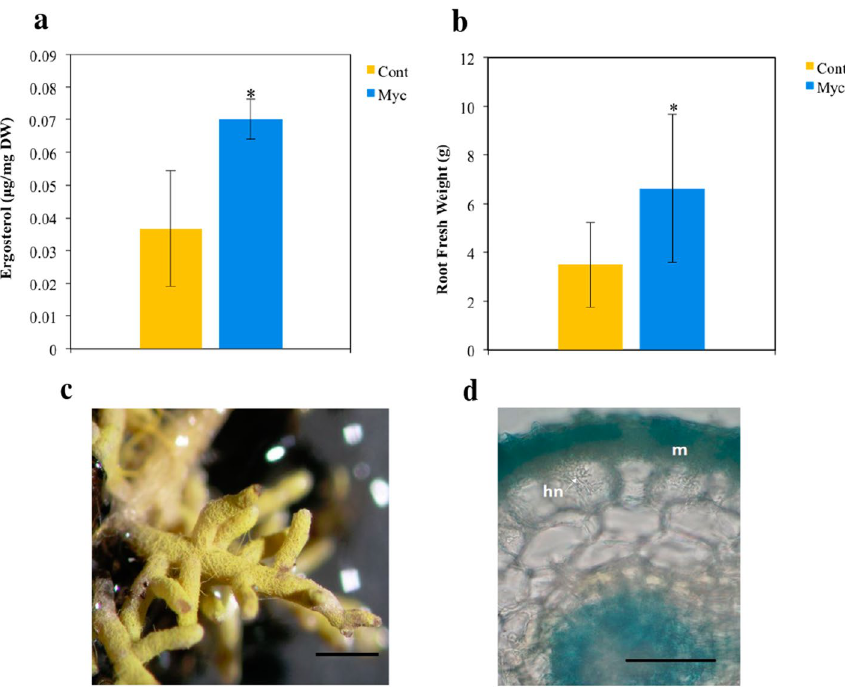
Figure 1. Fungal root colonization and plant growth of mycorrhizal (Myc) and non-inoculated (Cont) cork oak plants, 8 weeks after P. tinctorius inoculation. ( a ) Ergosterol root content. Data represent the mean of 3 independent biological replicates (each composed of a pool of 3 individual root systems) ± SD ( b ) Root fresh weight. Data represent the mean of 15 independent plants ± SD. *Indicates statistical differences at the level P < 0.05 [t-test for ( a ) and Man-Whitney U test for ( b )]. ( c ) Colonized root showing the hyphal mantle. Scale bar = 1 mm. ( d ) Representative trypan blue staining of a colonized root showing the fungal mantle (m) and the hartig net (hn). Scale bar = 50 μm.